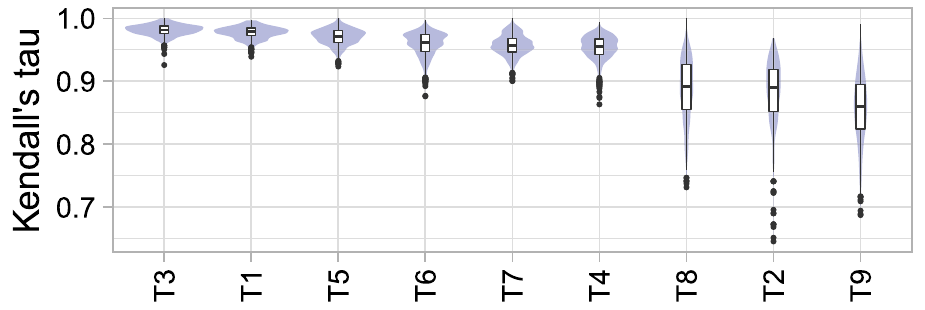
Figure 18. Violin plots for comparing ranking stability across tasks arranged by median Kendall’s τ